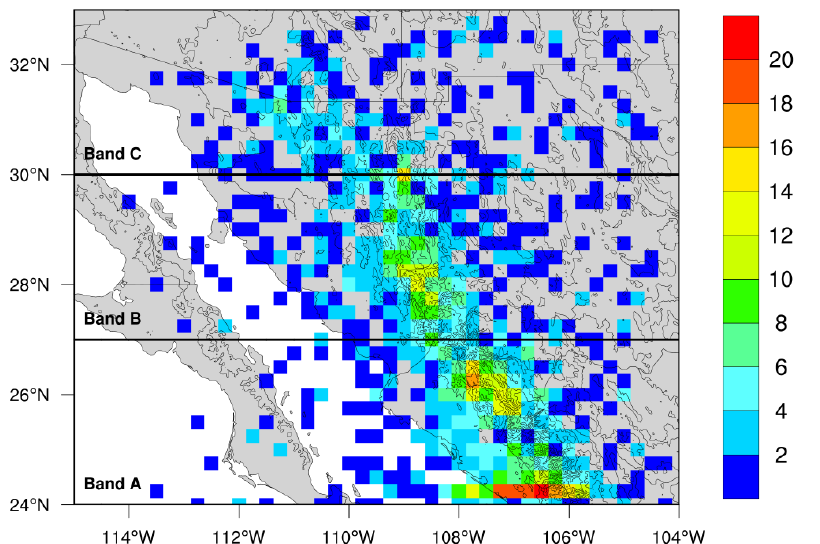
Figure 4. Geographic distribution of MCS counts during their initial stage based on the coordinates of the MCS centroid. The sums, indicated by the color bar, represent the total number of MCS (1995–1997) which initiated within a given 0.25 ◦ grid cell. The black line represents the border between the latitudinal bands called A, B, and C. The topography contours at intervals of 500 m are represented by the gray